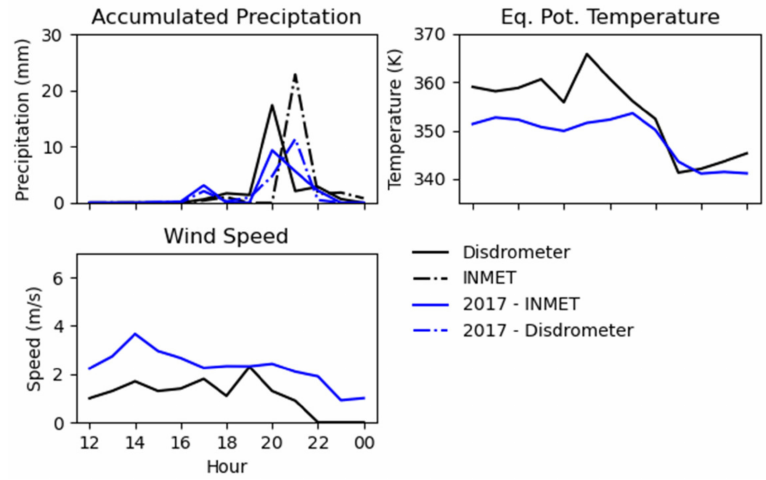
Figure 4. Time series of the accumulated precipitation (mm h − 1 ), the equivalent potential temperature (K), and the wind speed (m s − 1 ) for the observed at the Brazilian National Institute of Meteorology (INMET) Station (black solid lines) and at the disdrometer (black dashed line) and the 2017 scenario at the INMET Station point (blue solid line) and at the disdrometer (blue dashed line).